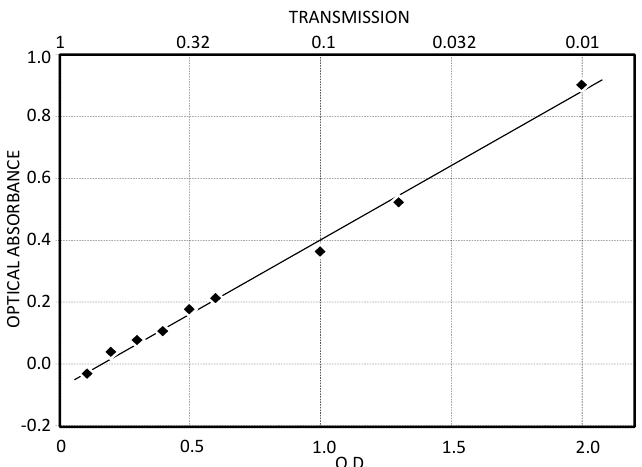
Figure 2. The graph shows that the optical density (O.D.) values of the calibrated neutral-density filters are linearly correlated with the measured values of the optical attenuation (absorbance) (coefficient of determination R 2 = 0.99). Therefore, the optical head of CleAir maintains a good linearity down to light transmissions as low as 1% of the virgin filter ones. The negative absorbance for the lowest O.D. is a consequence of a better coupling of the input light inside each filter. The O.D., optical absorbance and transmission are dimensionless parameters.